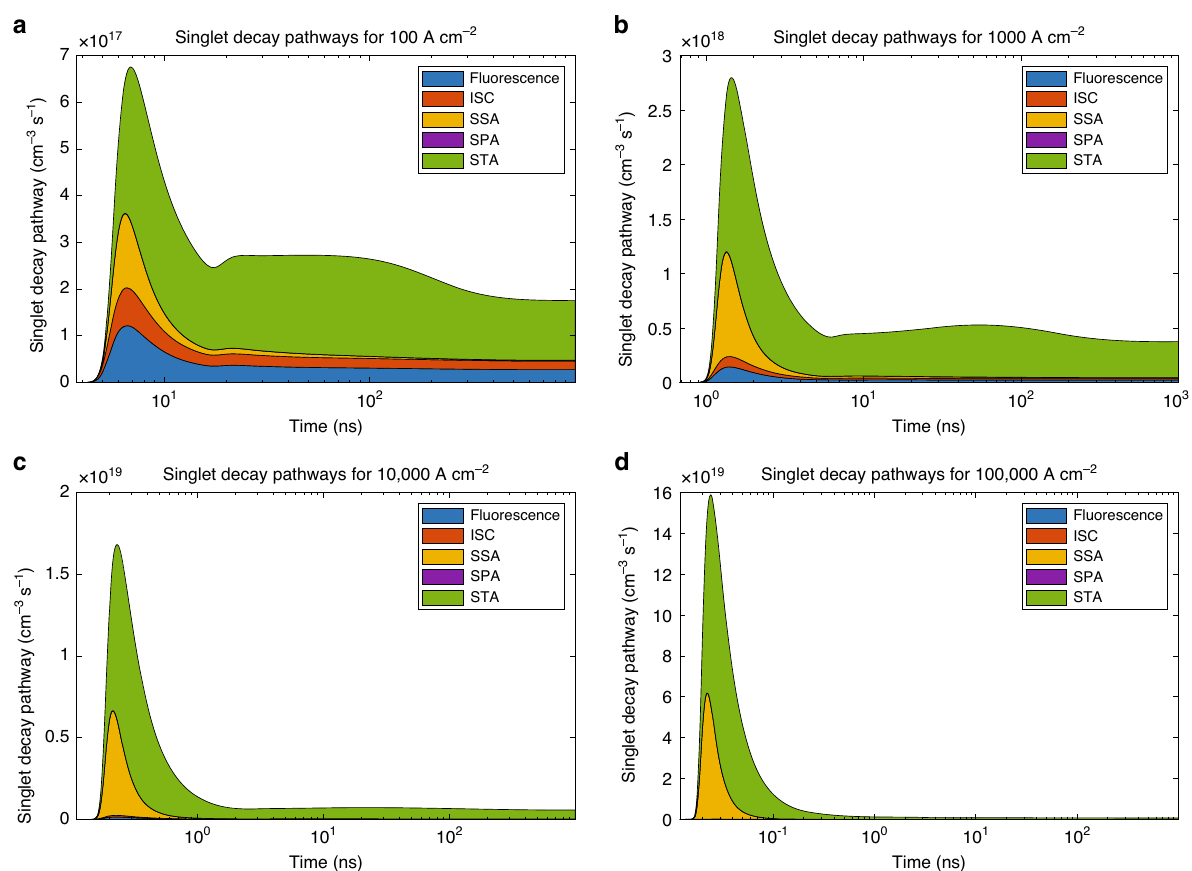
Fig. 5 Contributions of various singlet decay pathways plotted versus time. Here, ISC, SSA, SPA and STA stand for intersystem crossing, singlet – singlet annihilation, singlet-polaron annihilation and singlet – triplet annihilation, respectively. Results obtained for four different current densities are shown